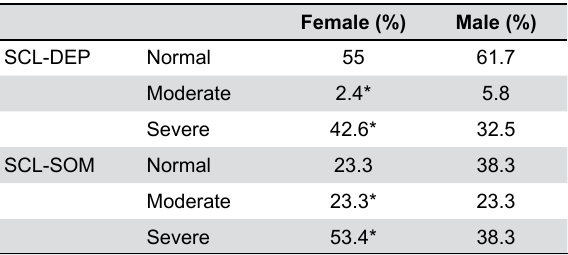
Table 4- Percentage of genders allocated according to the severity of Depression (SCL-DEP) and Somatization (SCL-SOM)